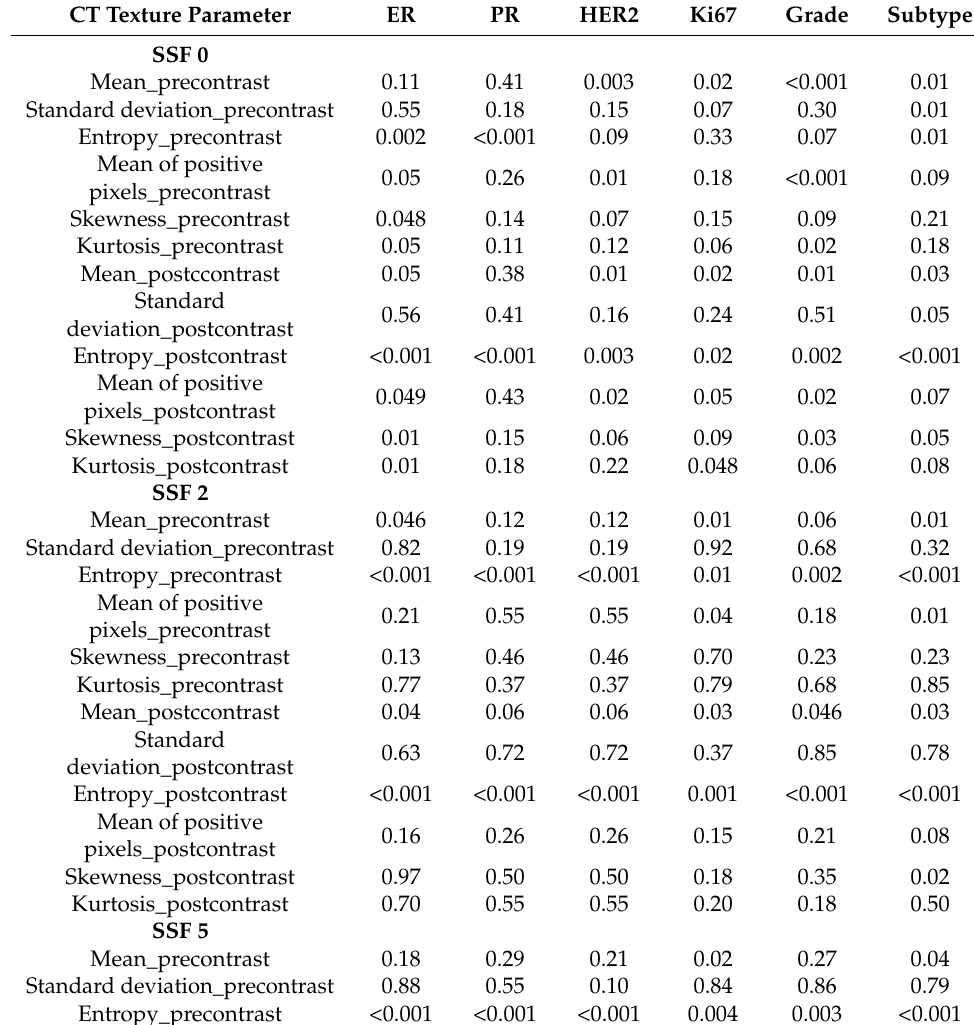
Table 3. p values for association between CT texture parameters and histological factors in the training